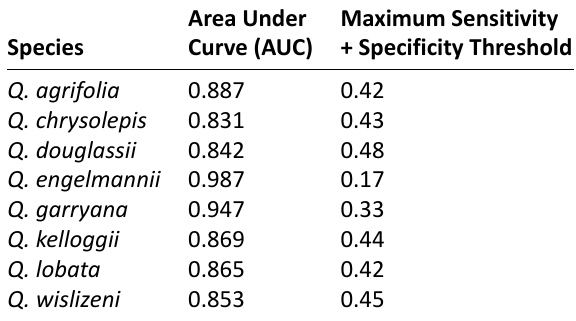
Table 2. AUC values from each species distribution